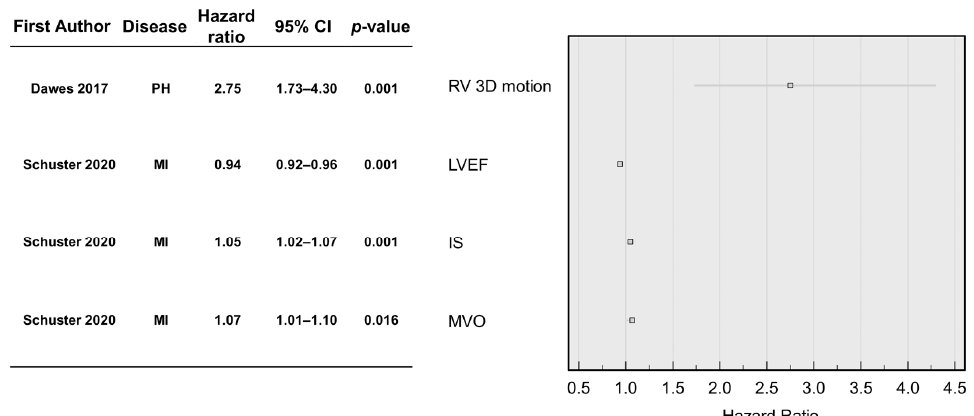
Figure 4. A forest plot of AIs using CMR parameters and their significance for the three-dimensional motion assessment model in pulmonary hypertension and automated volumetric, functional, and area assessment in myocardial infarction [8,11]. Abbreviations: 3D, three-dimensional; IS, infarction size; LVEF, left ventricular ejection fraction; MI, myocardial infarction; MVO, microvascular obstruction; PH, pulmonary hypertension; RV, right ventricle.